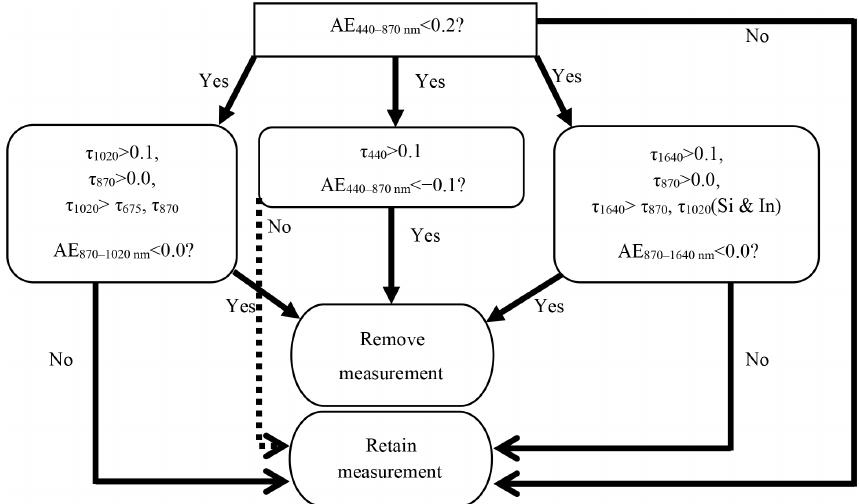
Figure 12. Flowchart of the reverse spectral dependence algorithm used to remove cloud contamination artifacts and instrument anomalies. The 1640nm wavelength is available on some Cimel model 5 instruments and all model T